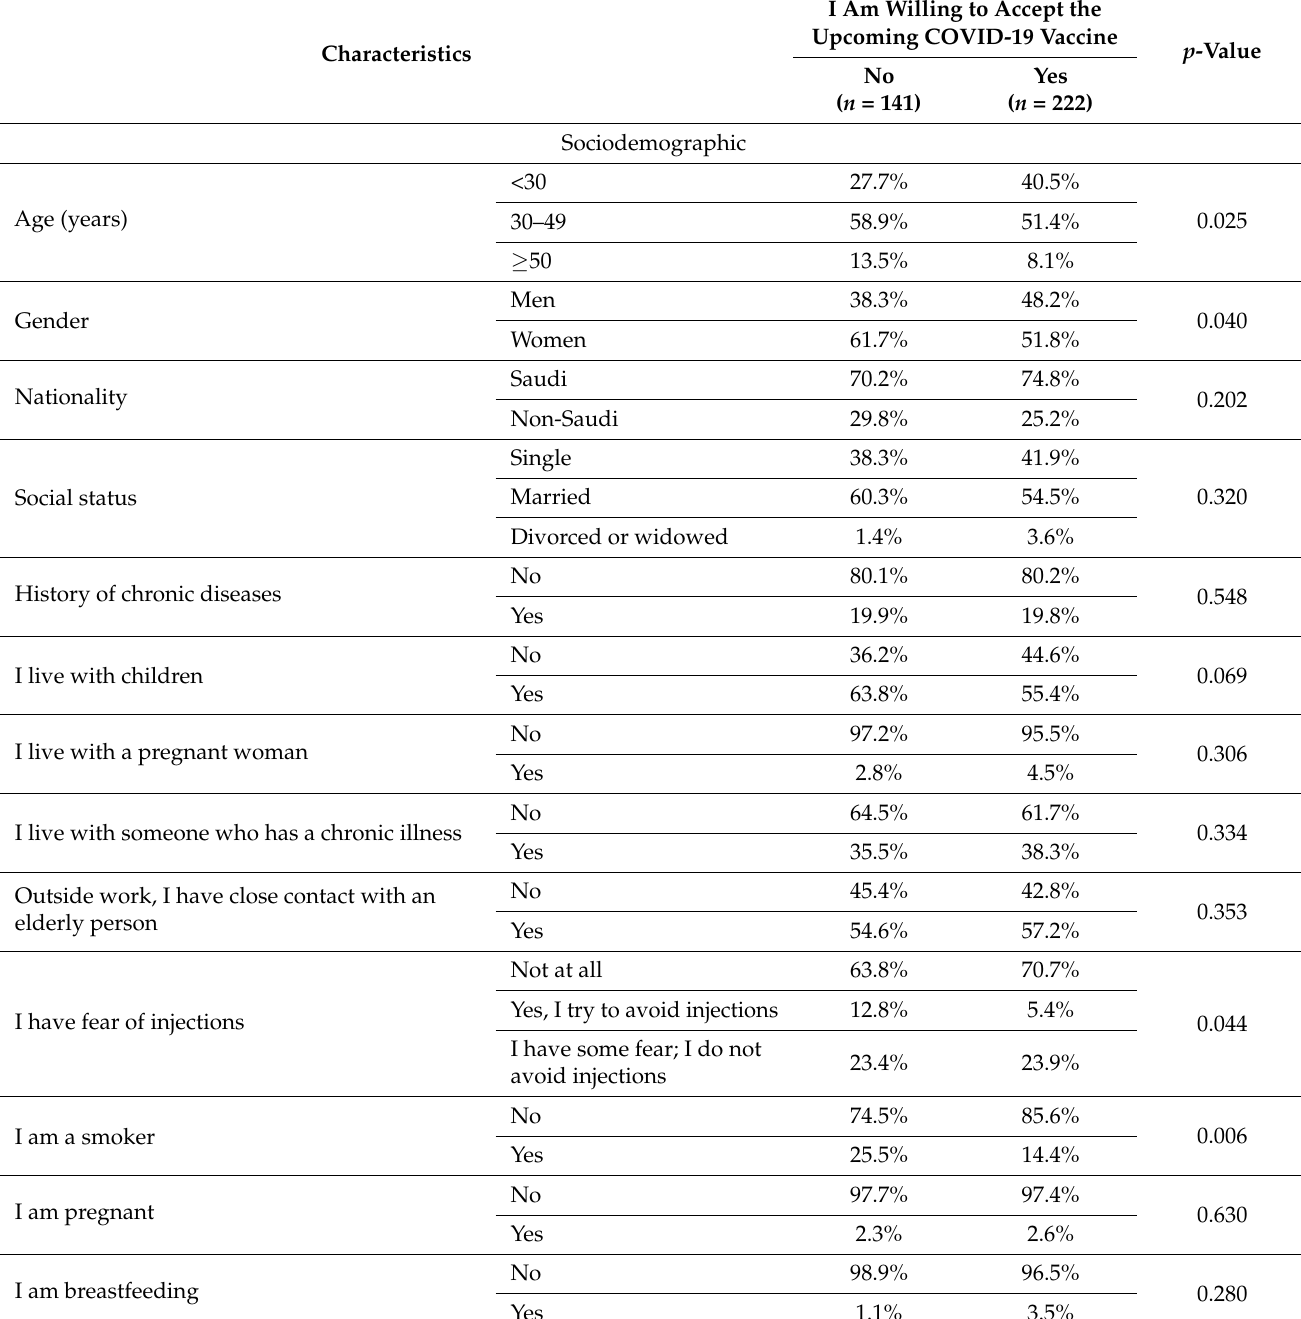
Table 1. Sociodemographic factors and influenza vaccination history as predictors of the healthcare workers’ COVID-19 vaccine